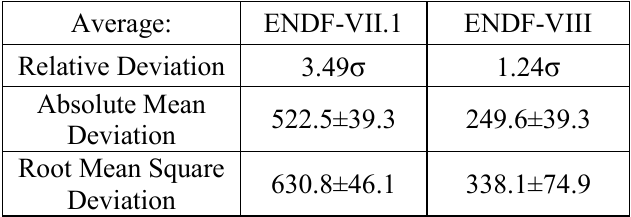
Table II. Average Deviations from Experimental Criticality: Comparison of ENDF-VII.1 and